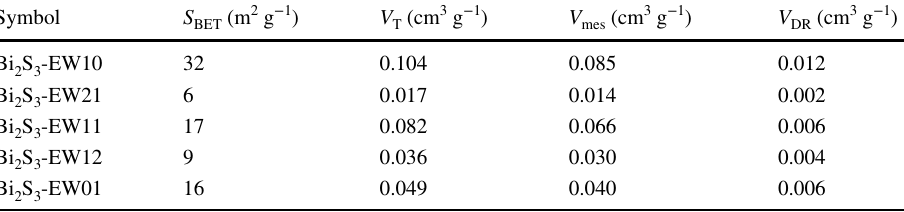
Symbol S BET (m 2 g −1